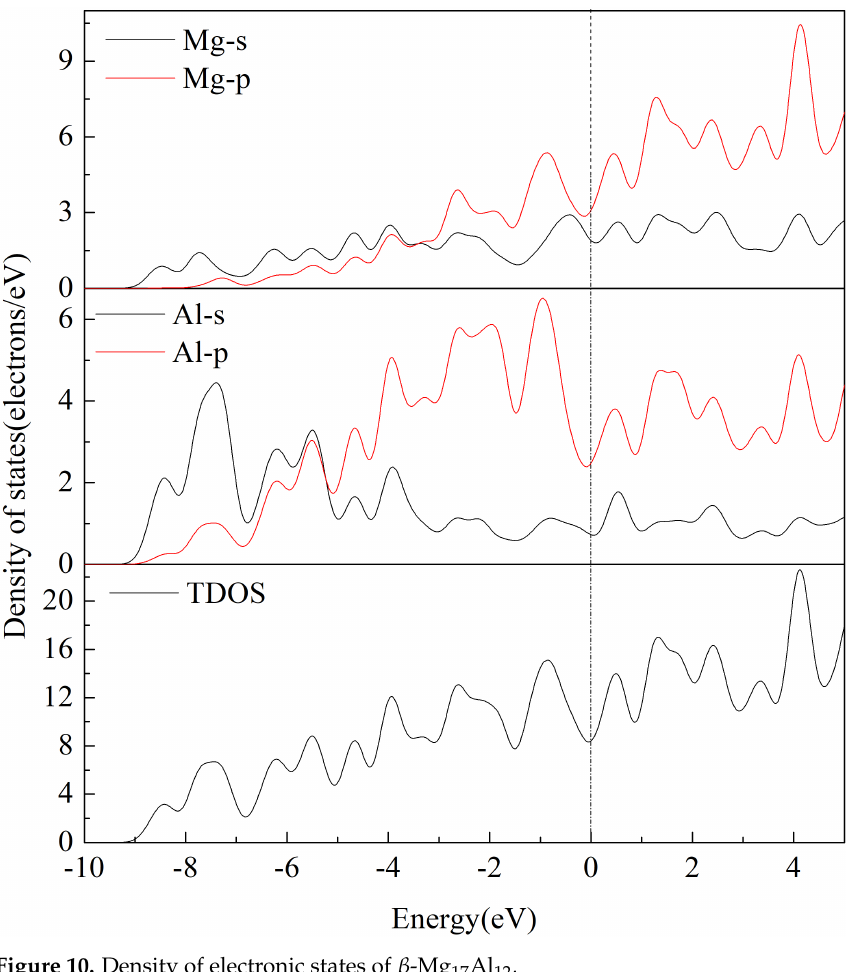
Figure 10. Density of electronic states of β -Mg 17 Al 12 .